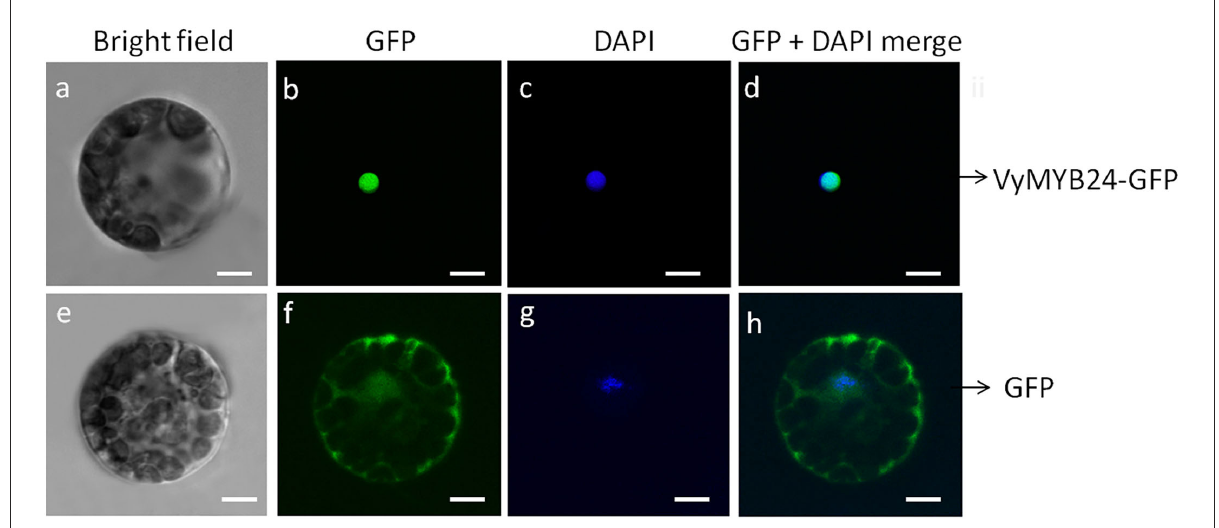
FIGURE2 Subcellular localization of the VyMYB24 protein in Arabidopsis leaf protoplasts. The fluorescent signal was detected by confocal laser-scanning microscopy. (a,e) Bright field; (b,f) GFP; (c,g) DAPI; (d,h) GFP + DAPI merge. Bars correspond to 10 µ m.